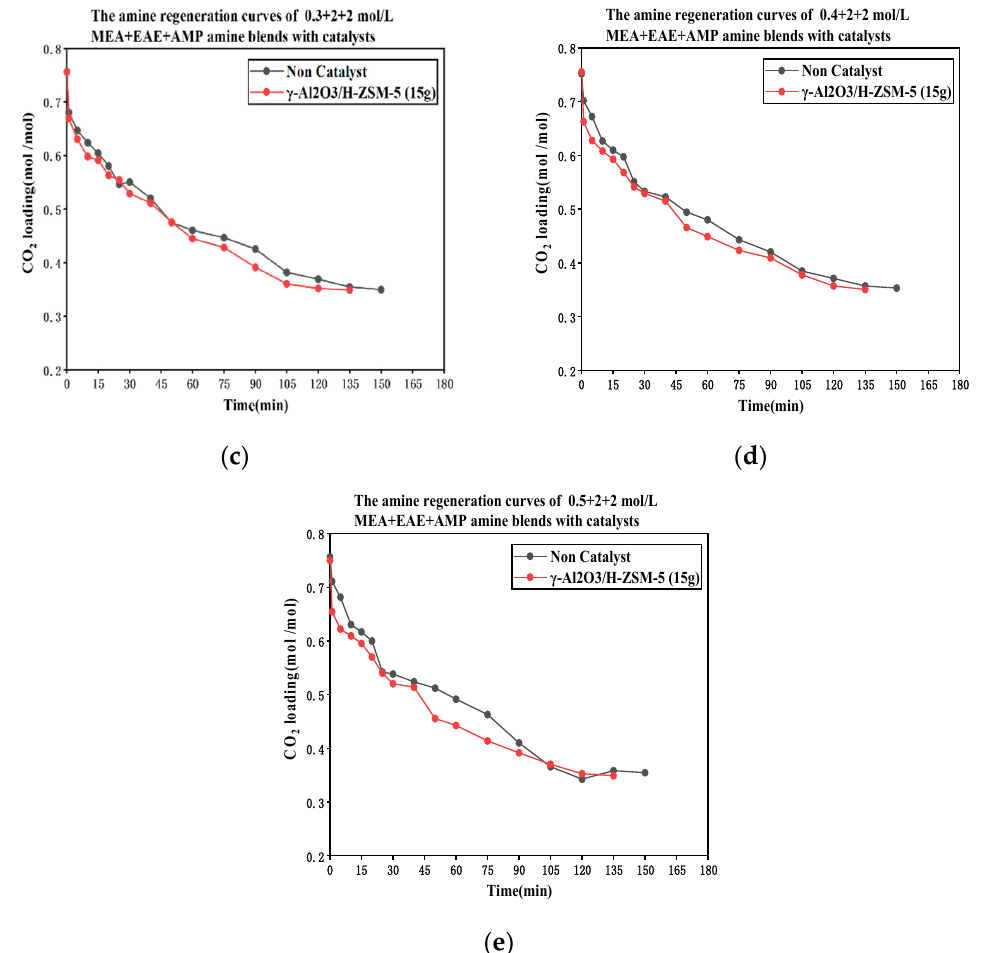
Figure 1. The CO 2 desorption profiles of MEA + EAE + AMP with catalysts within 0.1 + 2 + 2 mol/L– 0.5 + 2 + 2 mol/L. ( a ) 0.1 + 2 + 2 mol/L, ( b ) 0.2 + 2 + 2 mol/L, ( c ) 0.3 + 2 + 2 mol/L, ( d ) 0.4 + 2 + 2 mol/L, ( e ) 0.5 + 2 + 2 mol/L.